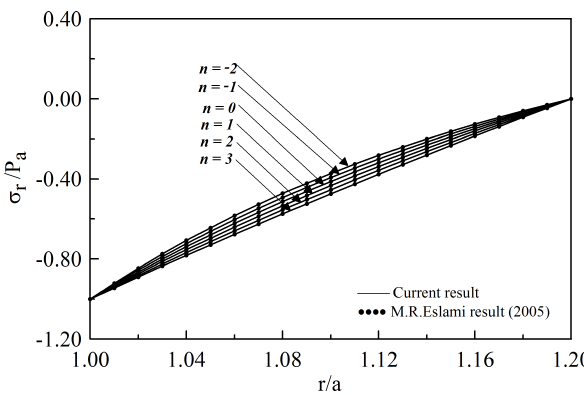
Figure 8: Radially distributed radial stress